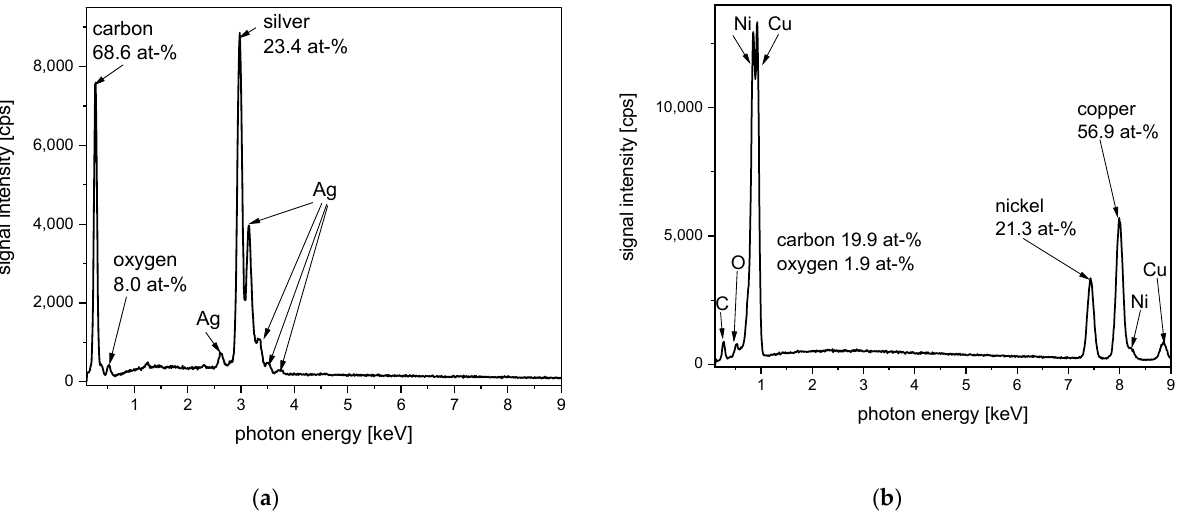
Figure 37. SEM images of two commercial textile products offered for electrosmog shielding (YShield EMR-Protection): ( a ) fabric type silver silk with shielding rate of 60 dB; ( b ) fabric type HNG80 with a shielding rate 80 dB.